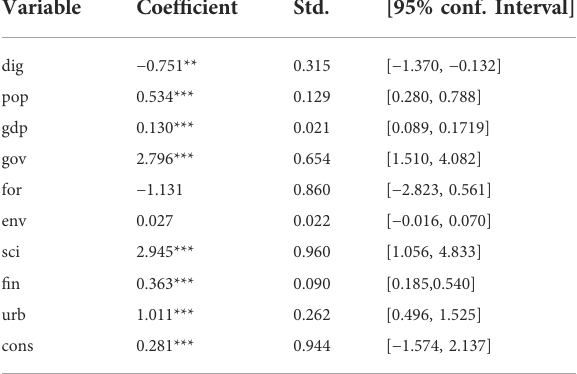
TABLE 3 Regression